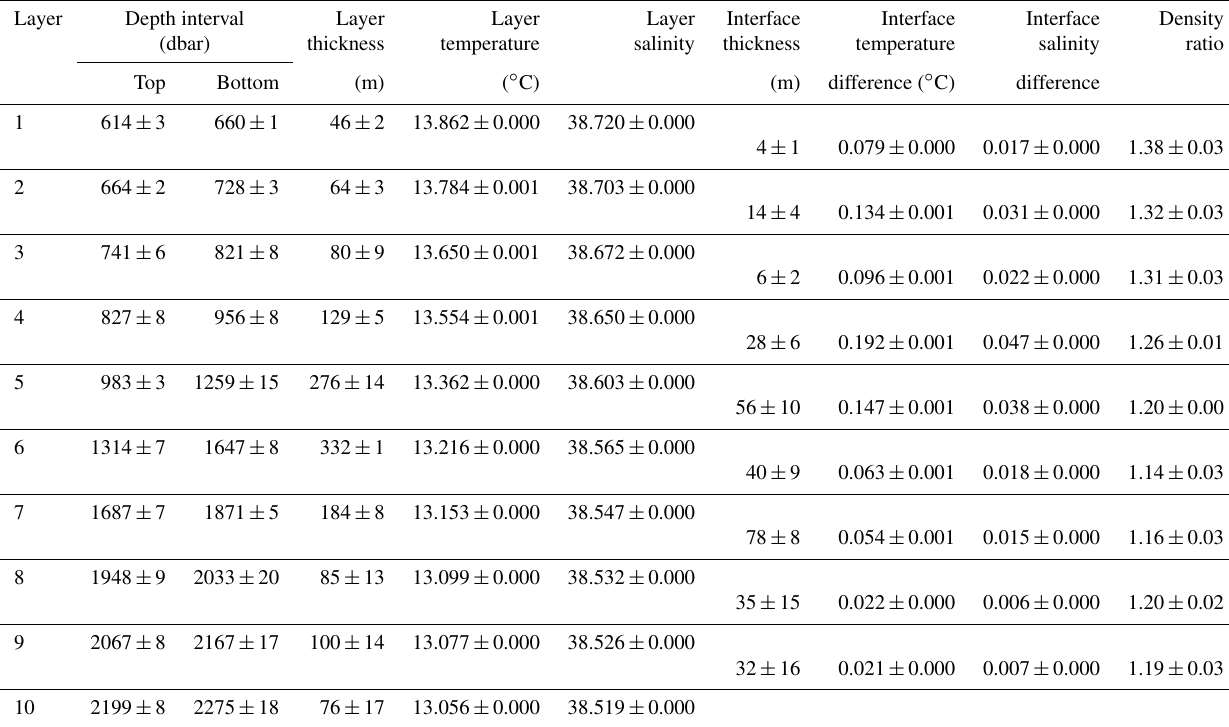
Table 3. Characteristics of the staircases in the Tyrrhenian Sea, extracted from the four casts carried out during the PEACETIME cruise (Fig. 3). The selected layers are thicker than 15m. The layer numbering increases with depth. Parameters are presented as the average value and standard deviation over the four casts